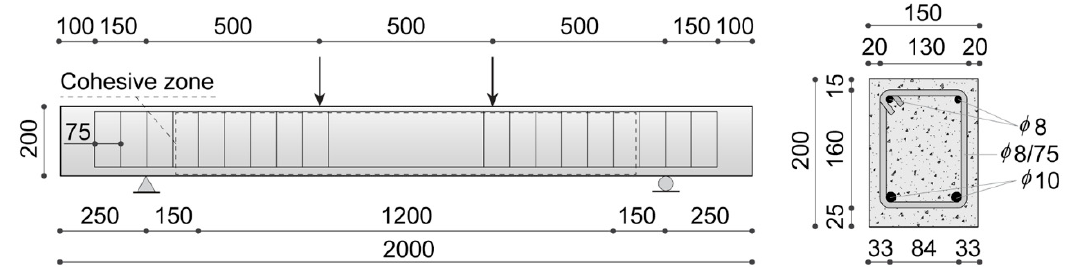
Figure 7. Geometric configuration, loading conditions and constrains of the simulated four-point bending test (all dimensions are expressed in mm). Table 3. Main mechanical properties of UHPFRC and steel materials.